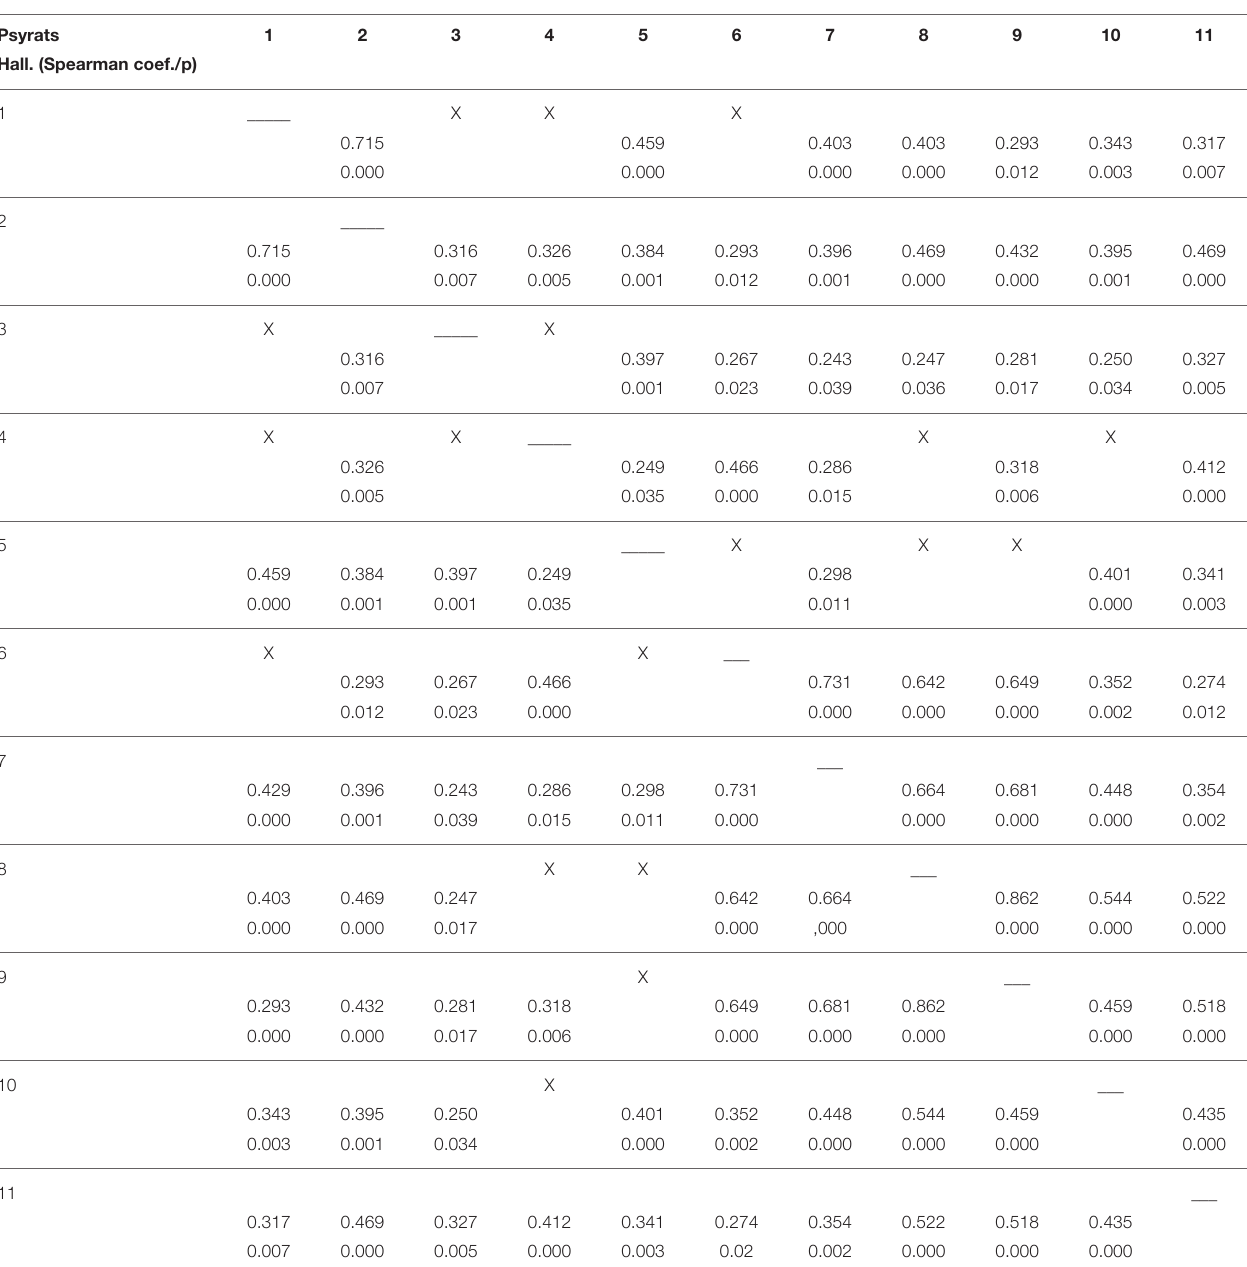
TABLE 4 | Correlation between hallucinations’ dimensions.